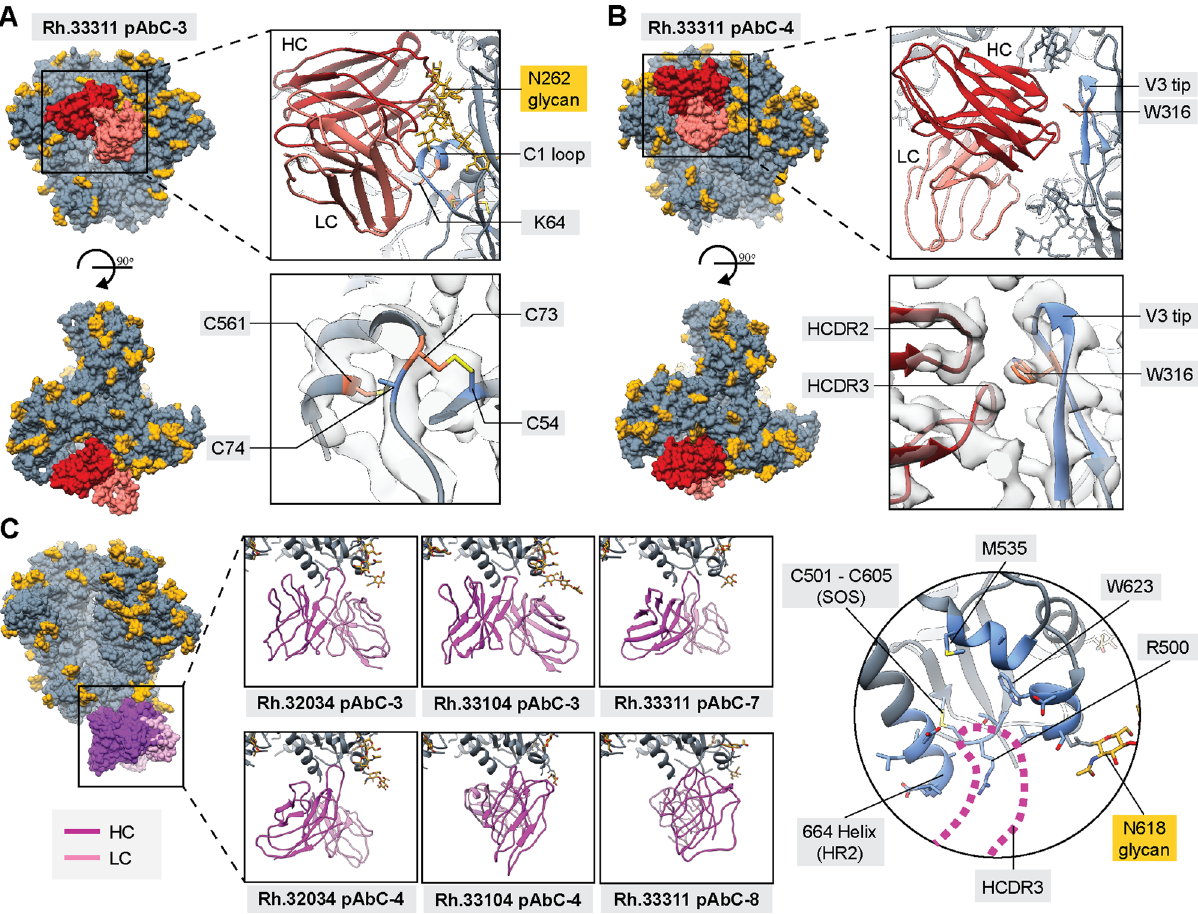
Fig. 4 Structural analysis of non-neutralizing antibody responses. Structures of BG505 SOSIP antigens in complex with polyclonal antibodies targeting gp120 – gp120 interface ( A , B ) and base epitopes ( C ). BG505 SOSIP trimers are shown in gray with N-linked glycans in golden yellow. Antibodies are colored using the same scheme as in Figs. 1 and 2. Inferred heavy and light chains for each antibody are represented in different colors and labeled in each panel (HC and LC, respectively). The most relevant epitope/paratope components are indicated in the panels. Surface representation is used for the full immune complex (left side of each panel). Trimer residues in direct contact with the antibodies are colored blue (ribbon and stick representation). Engineered stabilizing residues are represented as sticks and colored orange. EM Map is displayed as transparent light gray surfaces in panels ( A ) and ( B